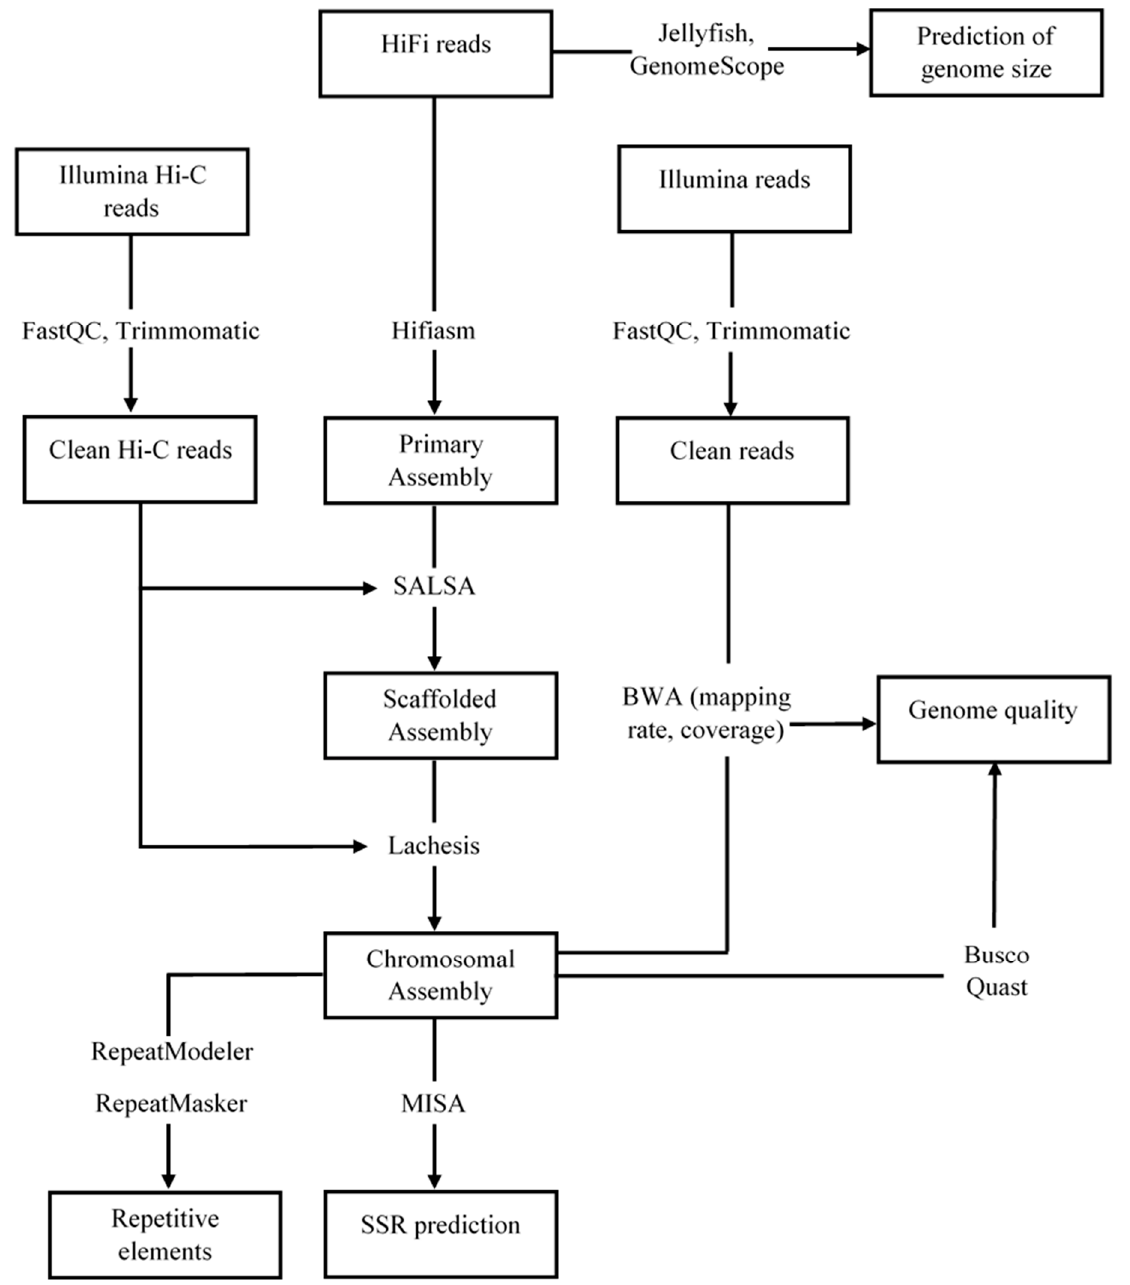
Figure 1. Detailed workflow for de novo whole-genome assembly and annotation.